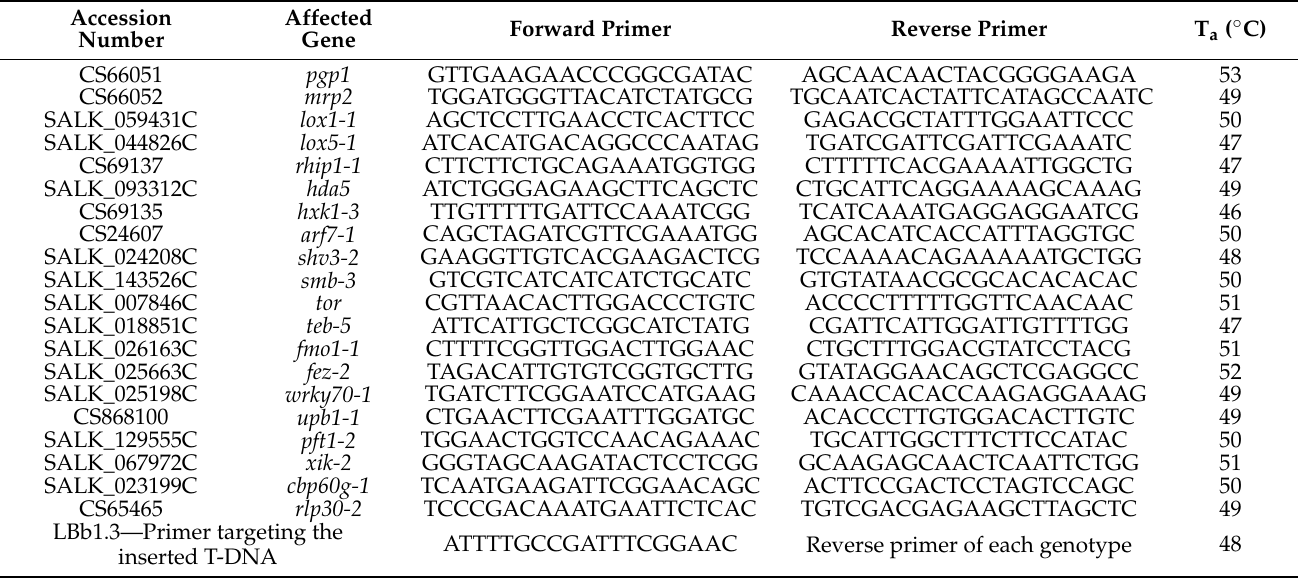
Table A1. Primer sequences used to screen mutants for homozygosity. Sequences were retrieved from the T-DNA Express website (http://signal.salk.edu/cgi-bin/tdnaexpress, accessed on 13 March 2018) through the iSect tool, except for the pgp1 , the wrky70 and the cbp60g primers, which were designed using Geneious Prime v.2019.2.1. LBb1.3 was used as left border primer to detect the inserted